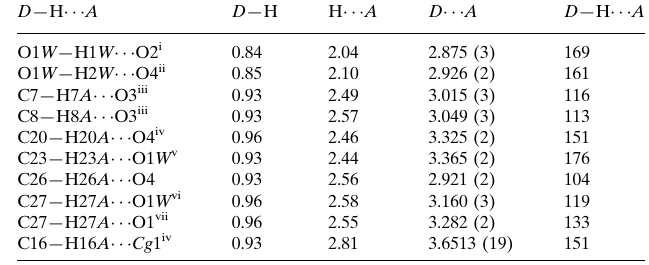
Hydrogen-bond geometry (A˚ , (cid:3)